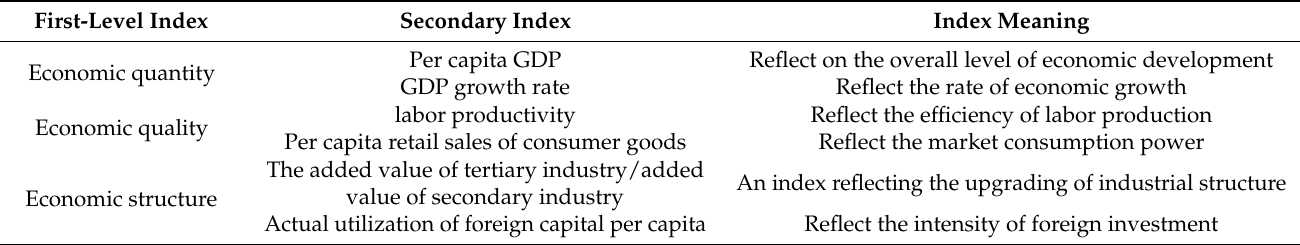
Table 1. Evaluation Index System of Economic Polarization